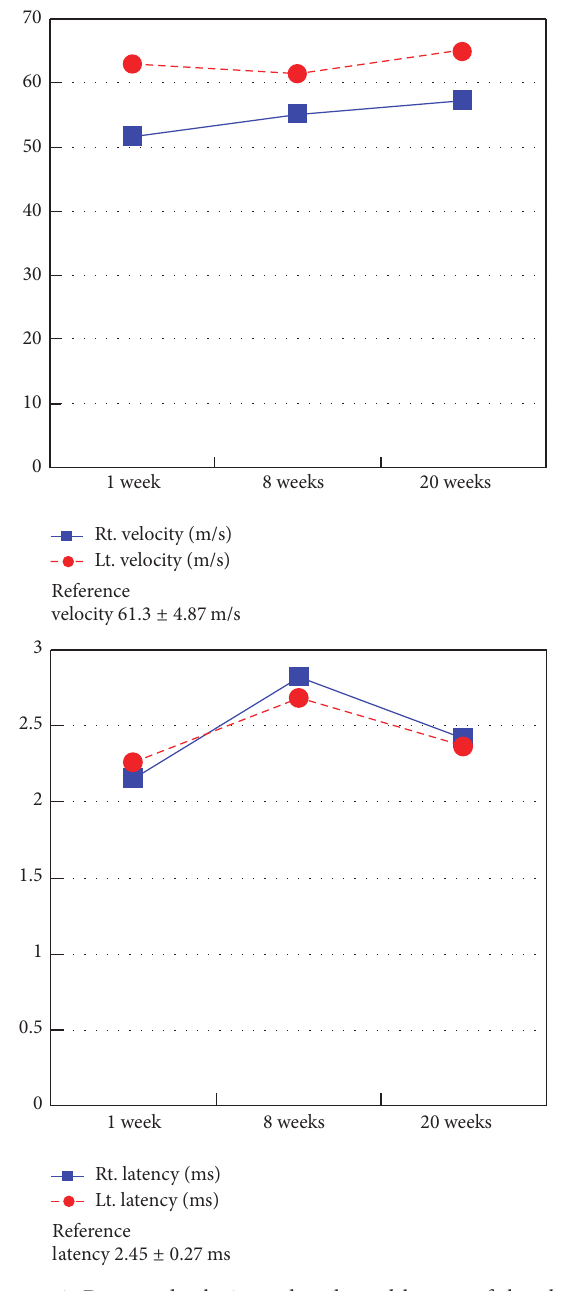
Figure 8: Decreased velocity and prolonged latency of the ulnar nerve improved